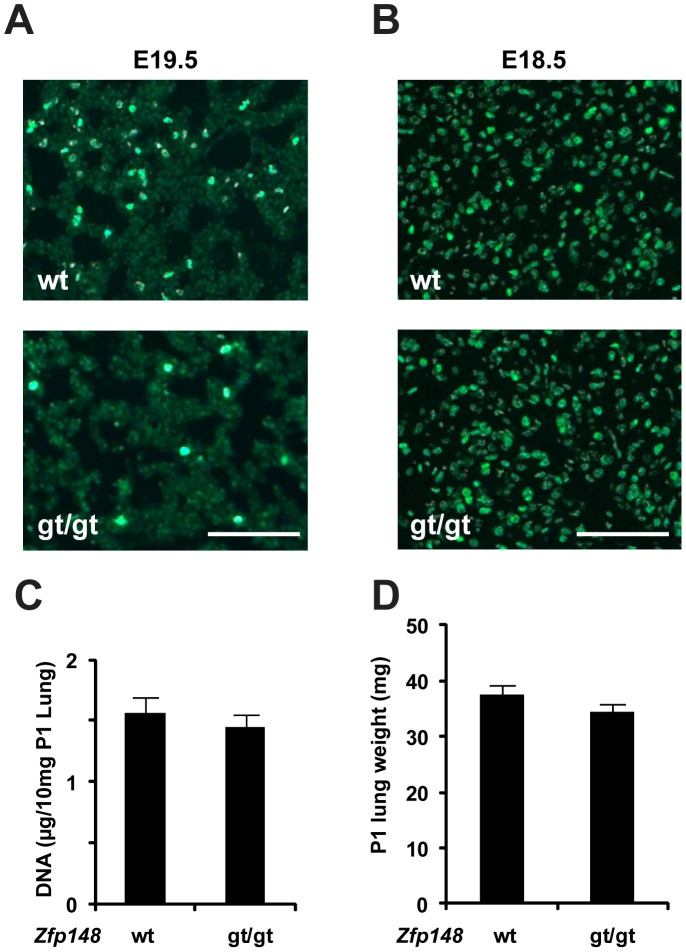

Zfp148 deficiency reduced cell proliferation at the saccular stage of lung development.(A, B) Photomicrographs showing BrdU labeling of E19.5 (A) and E18.5 (B) lungs, respectively, from wt and Zfp148gt/gt mice. (C) DNA content per 10 mg lung tissue (n = 5). (D) Lung wet weight at P1 (n = 12). Scale bars, 100 µm.